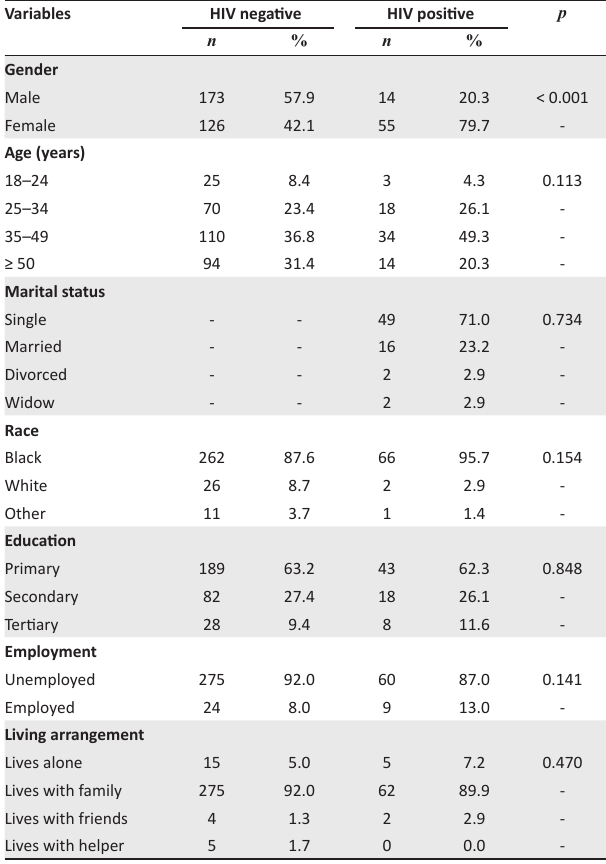
TABLE 3: Bivariate analysis of factors associated with HIV